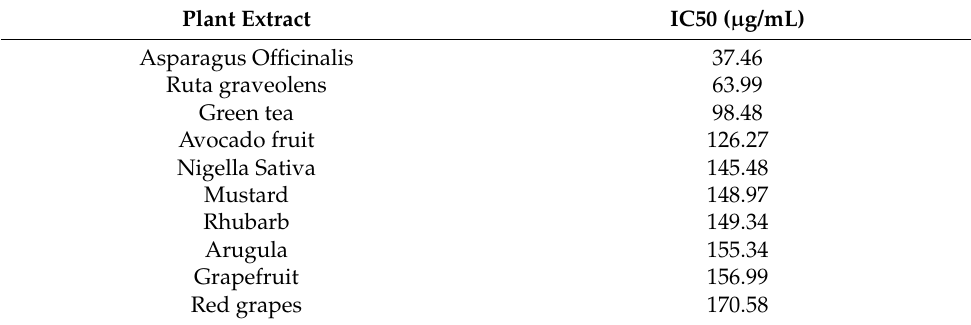
Table 1. IC50 of plant extracts on HepG2 cells after treatment for 48